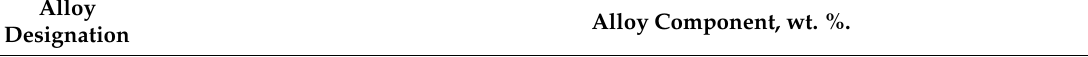
Table 2. Chemical composition of the alloys used in this